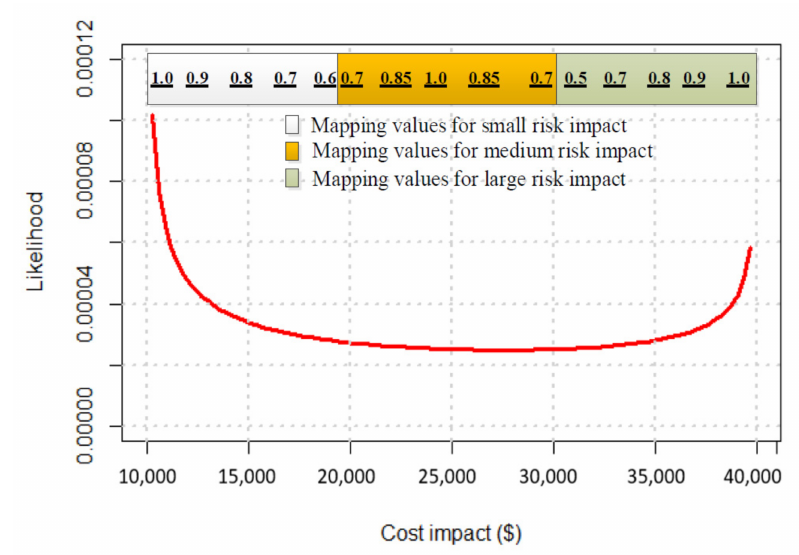
Figure 10. Marginal Beta distribution of cost-risk impact after changing membership function of ( C ).